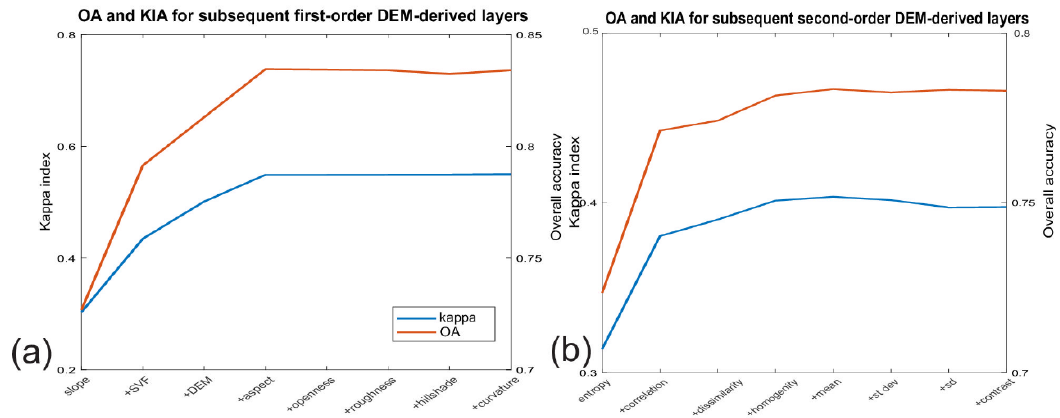
Figure 6. Kappa and accuracy in reference to subsequently added ( a ) first-order DEM-derived layers and ( b ) second-order DEM-derived layers.